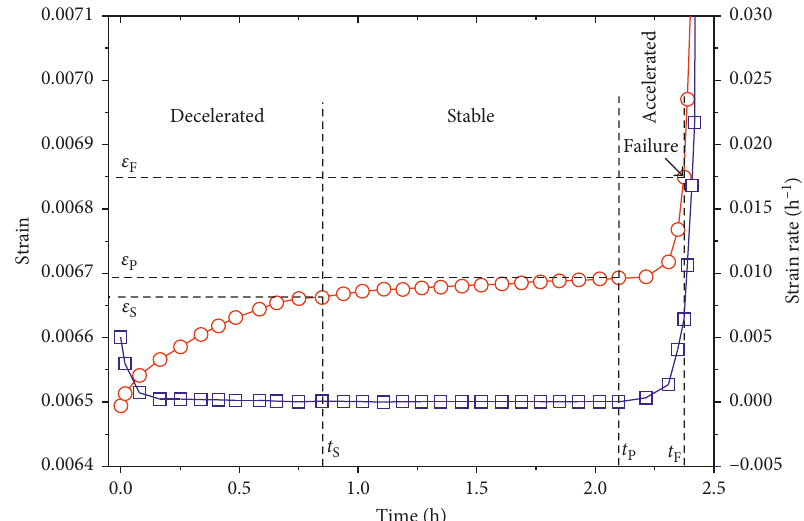
Figure 4: Strain of mudstone and strain rate over time (under dry condition). t S is the time point when the rock specimens enter the stable rheological stage from the decelerated rheological stage. ε S is the strain value at this moment. t P is the time point when the rock specimens enter the accelerated rheological stage from the stable rheological stage. ε P is the strain value at the boundary point between the stable rheological stage and the accelerated rheological stage. t F is the time point when the final failure of rock specimens occurs. ε F is the strain value at the time of failure.